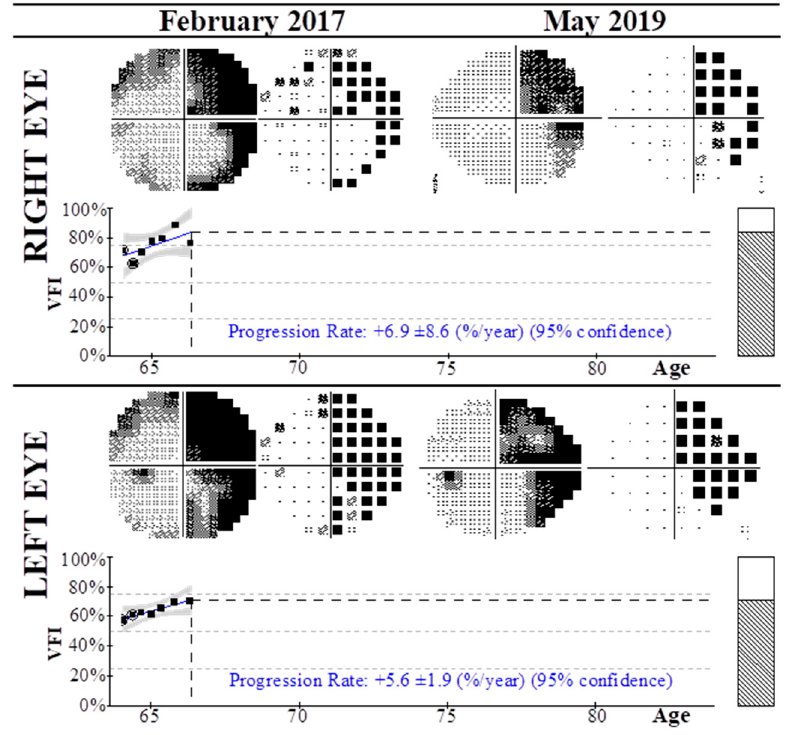
Figure 1. Visual field test using the Humphrey field analyzer and 30-2 algorithm of a case of right homonymous incomplete hemianopia after left occipital lobe stroke (Stroke06) from February 2017 to May 2019. In 2017 the patient was treated with CoQ10 and vitamins until May 2019, with progressive improvement of the visual field index in both eyes. Progression rates at 95% confidence level are shown.